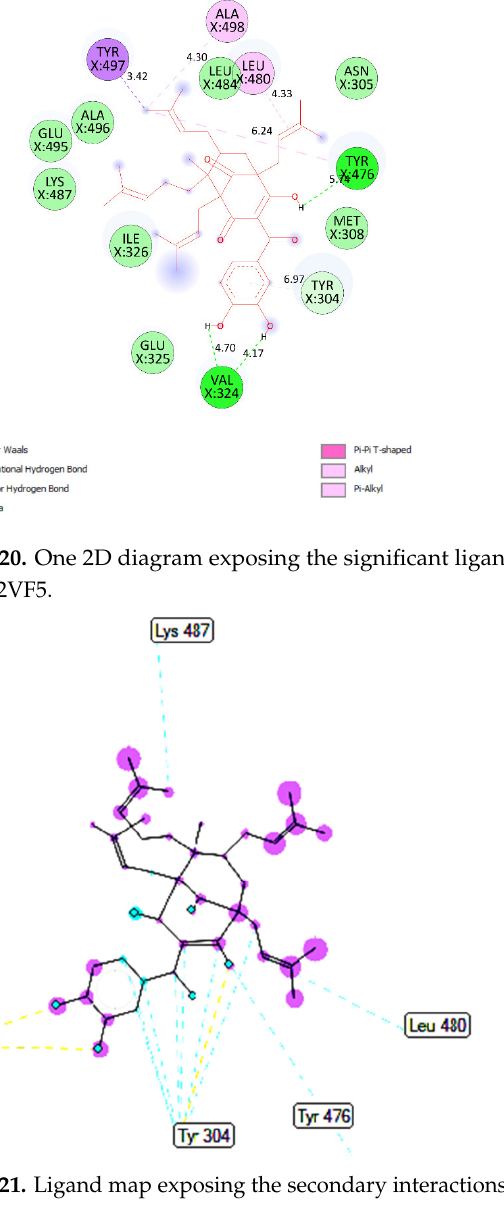
Figure 21. Ligand map exposing the secondary interactions between pose 35/200 and receptor 2VF5.